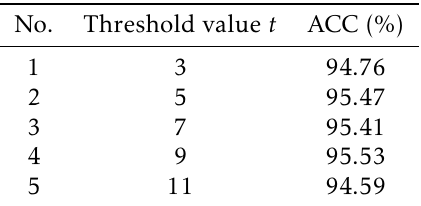
Table 3. Rice classification accuracy when changing